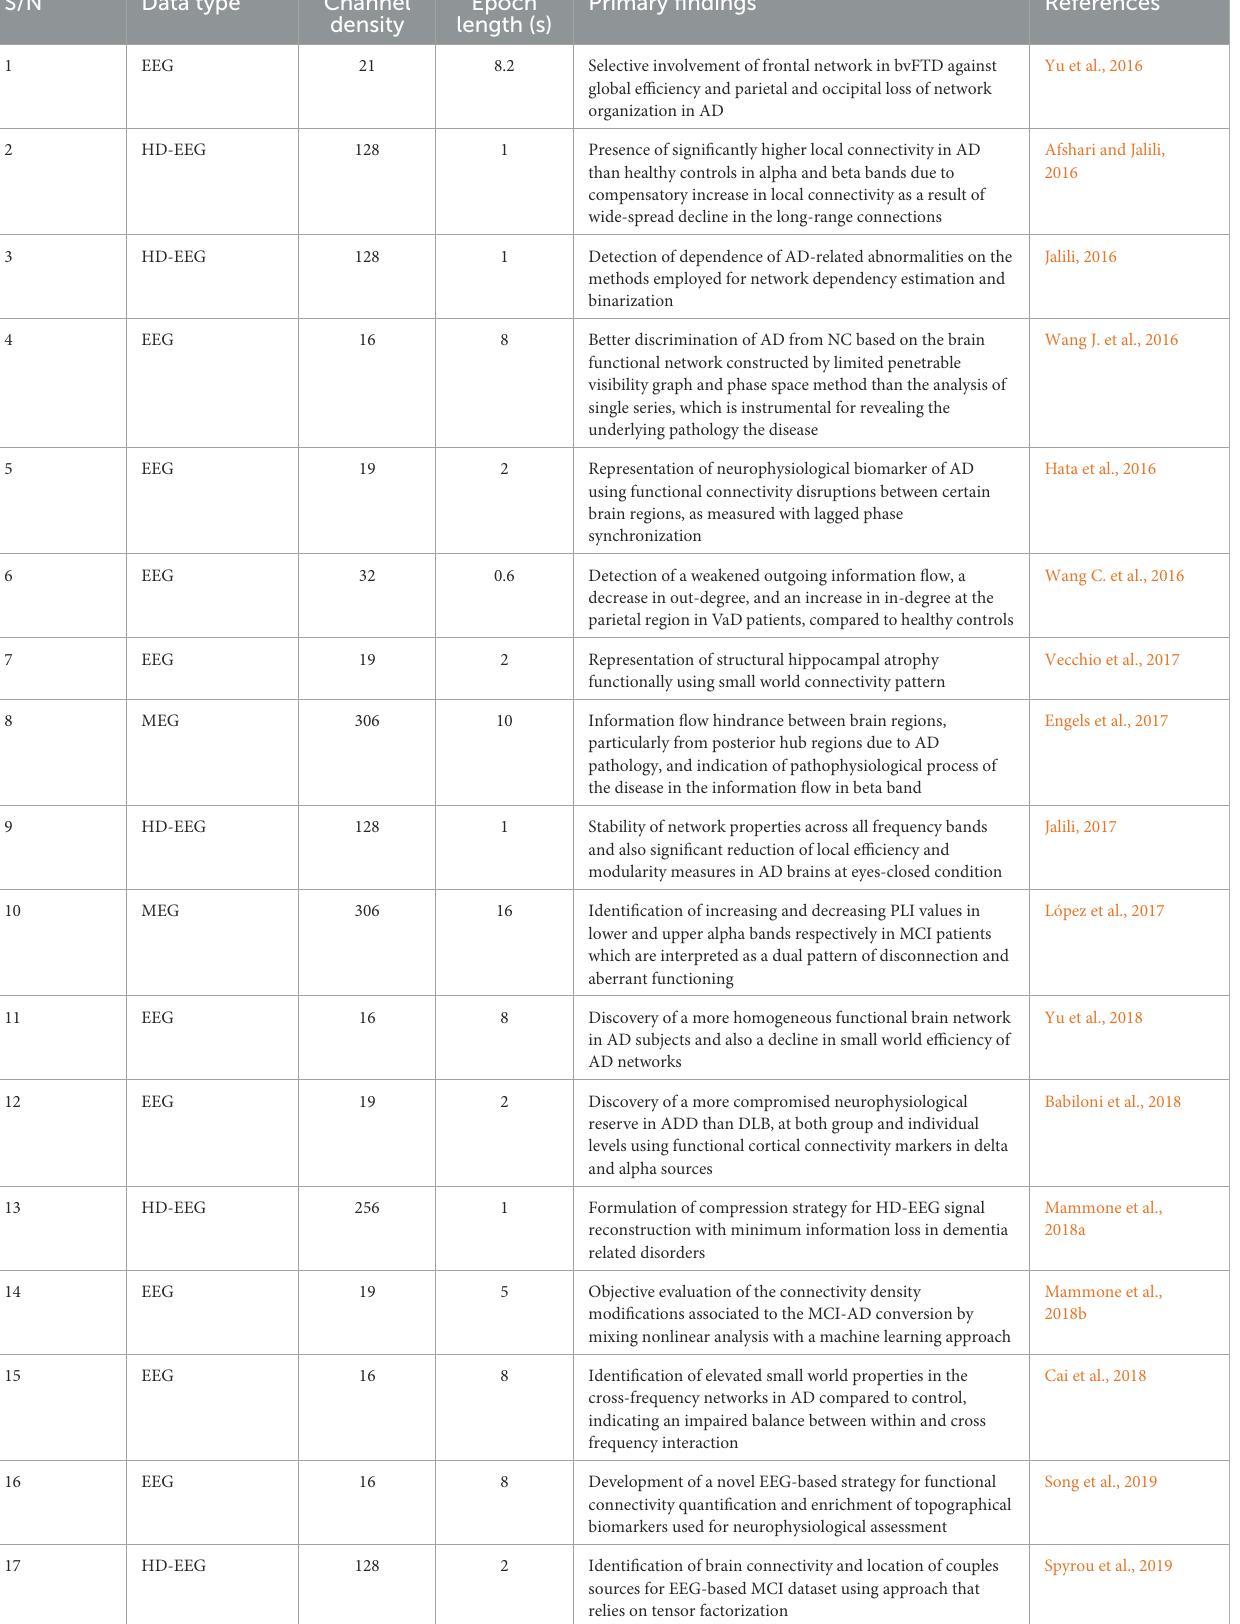
TABLE 4 Data type, channel density, epoch length and primary findings of the reviewed